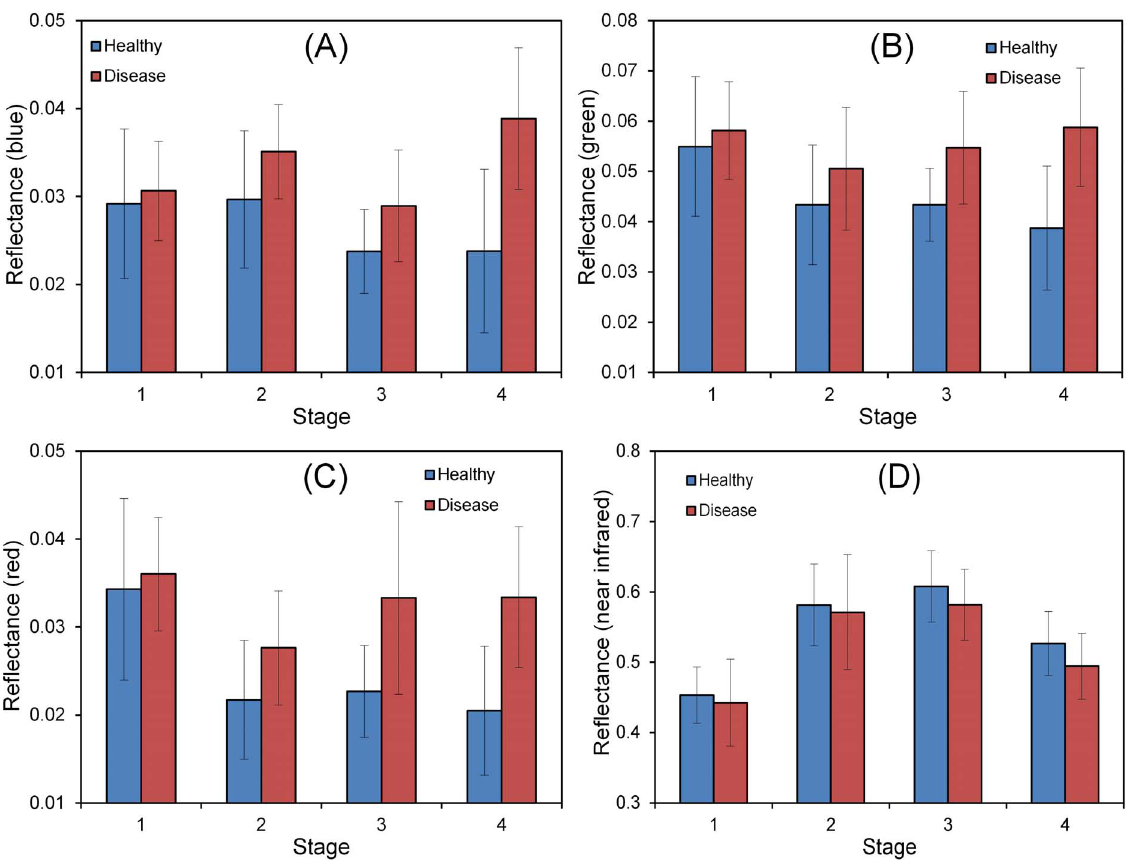
Figure 4. Means and standard deviations (small bars) of reflectance of each HJ-CCD band from both healthy and disease plots at different stages. A–D indicates figures of blue, green, red and near infrared channels.